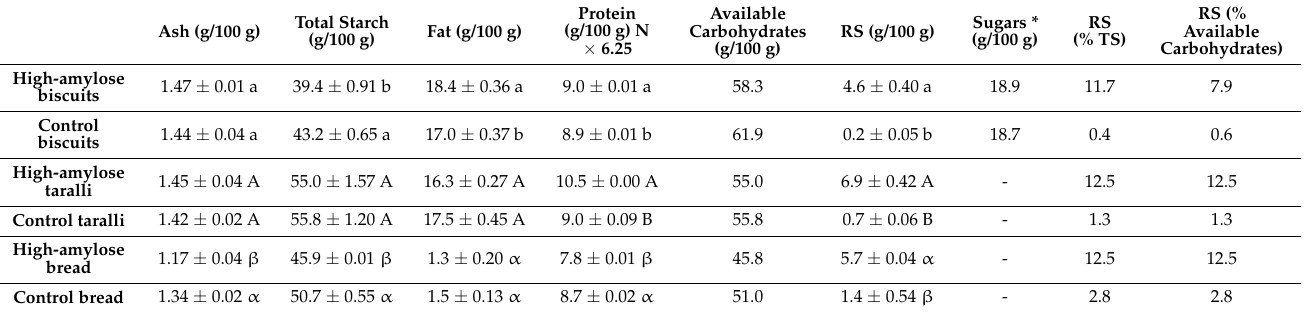
Table 3. Chemical composition (% f.w.) of high-amylose and control bakery